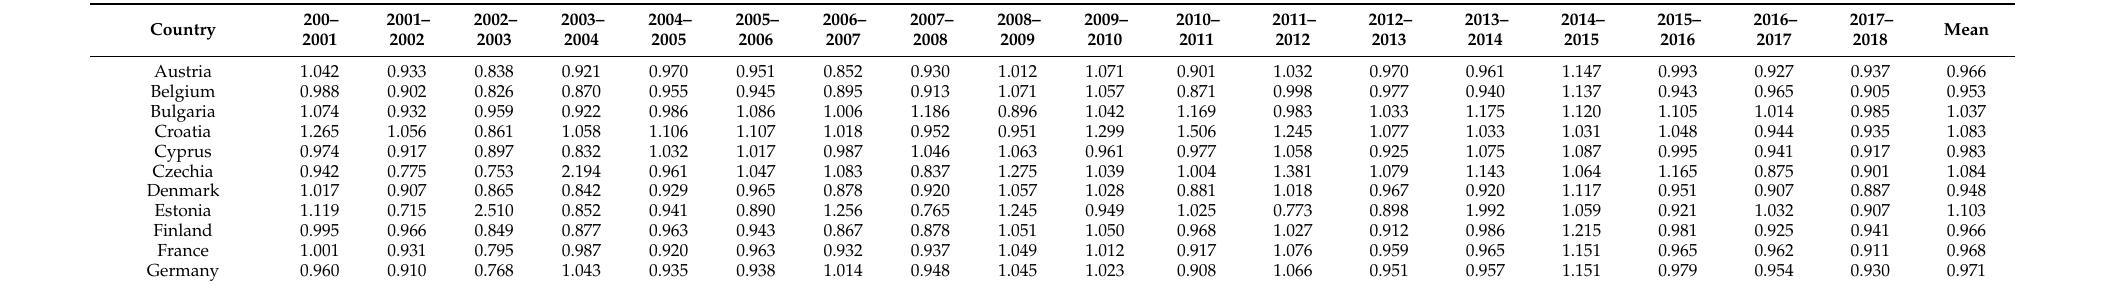
Table 5. Malmquist–Luenberger productivity